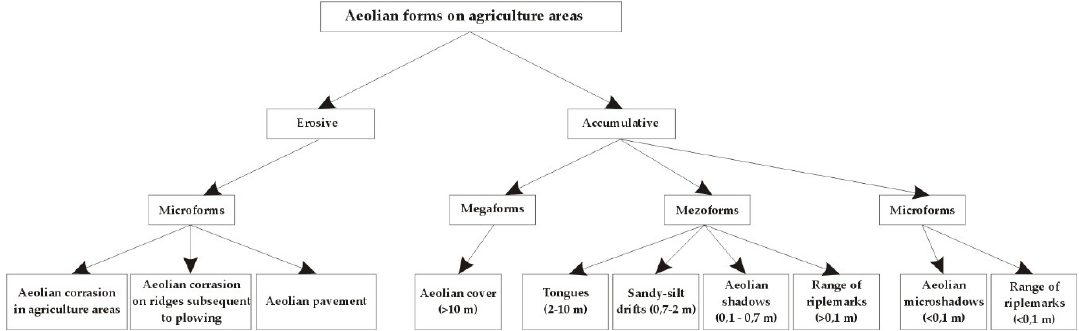
Figure 10. Diagram of aeolian forms formed on croplands.